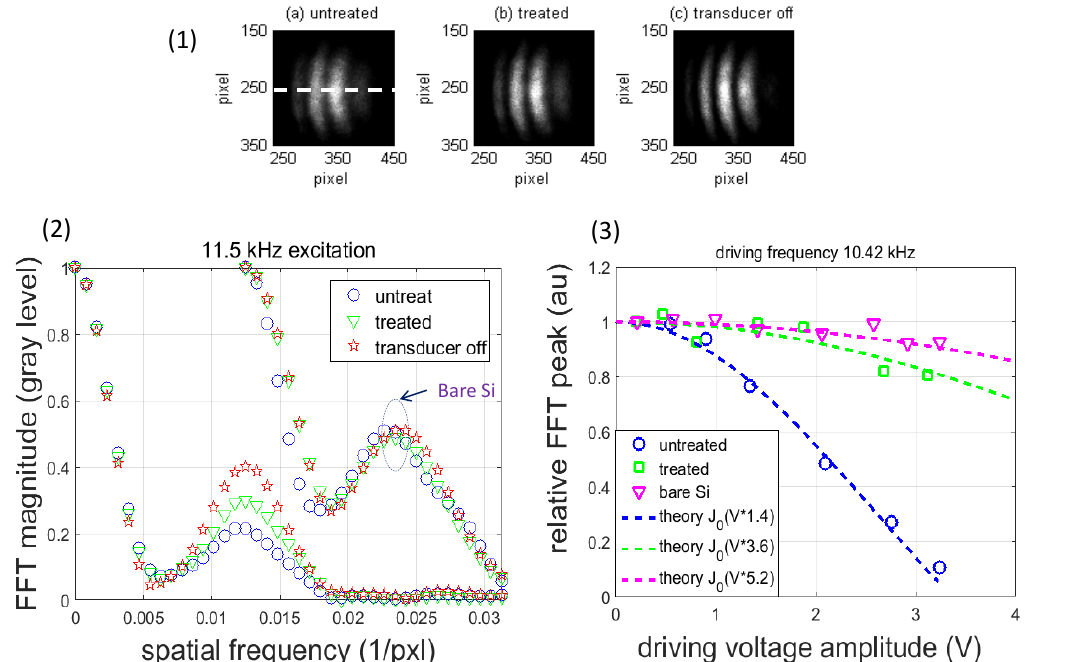
Figure 3. ( 1 ) Examples of fringe patterns; ( 2 ) Fourier spectra of intensity along the horizontal line indicated in Fringe Pattern ( a ); and ( 3 ) driving-voltage dependence of spectral peak value relative to the transducer-off (null driving voltage)